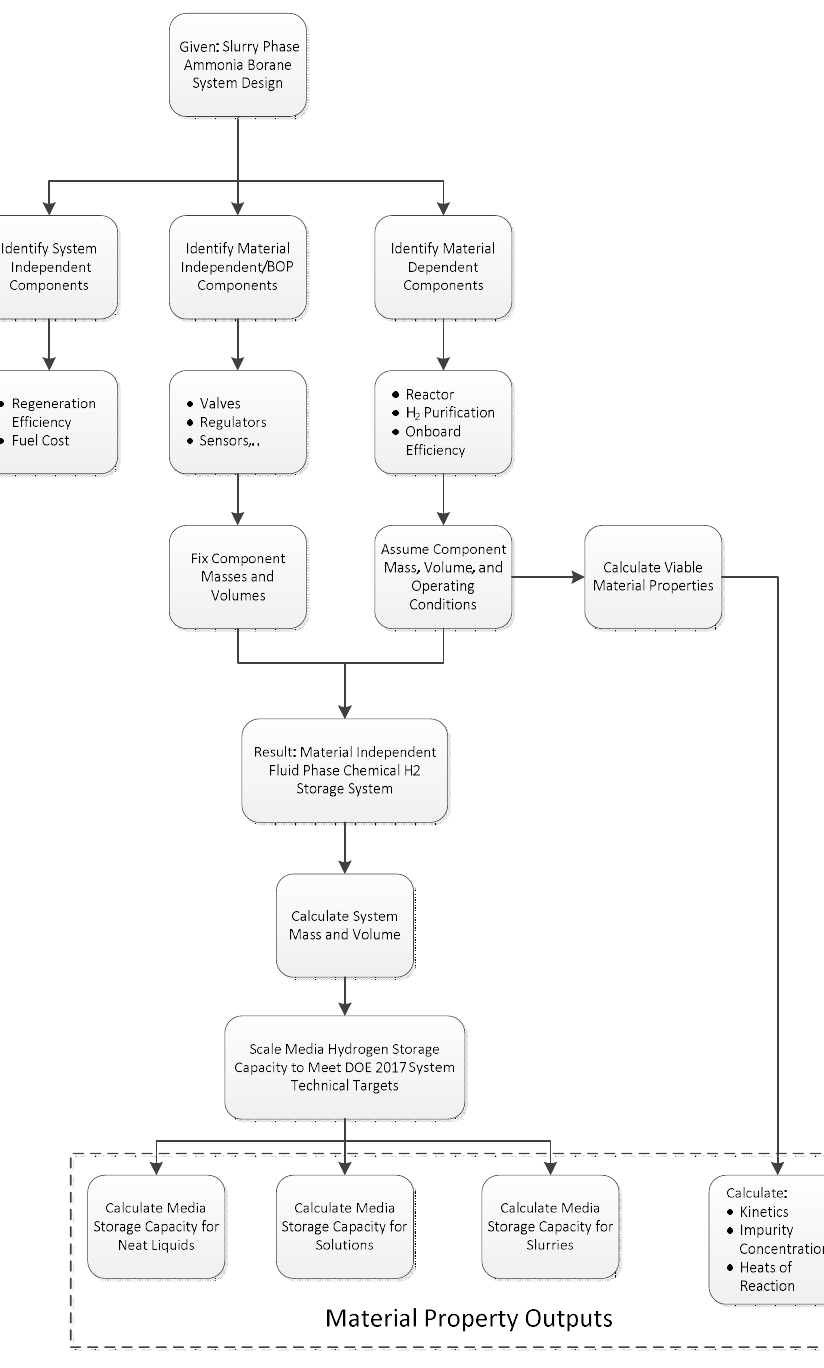
Figure 28. Modeling methodology flow chart.